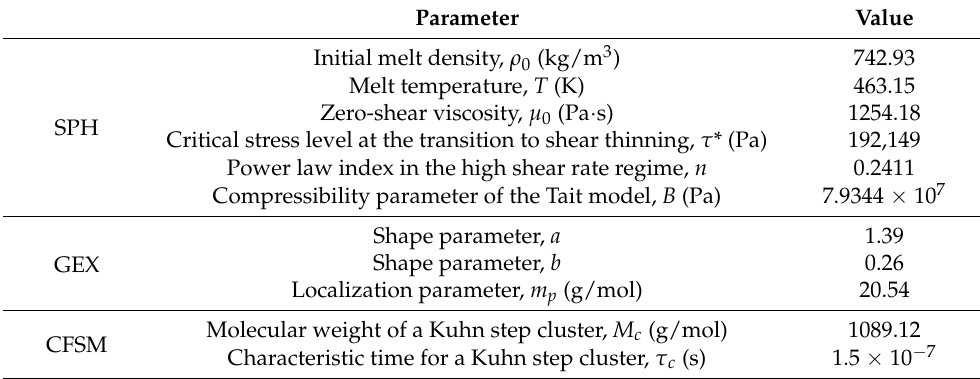
Table 1. The properties of Marlex 9006